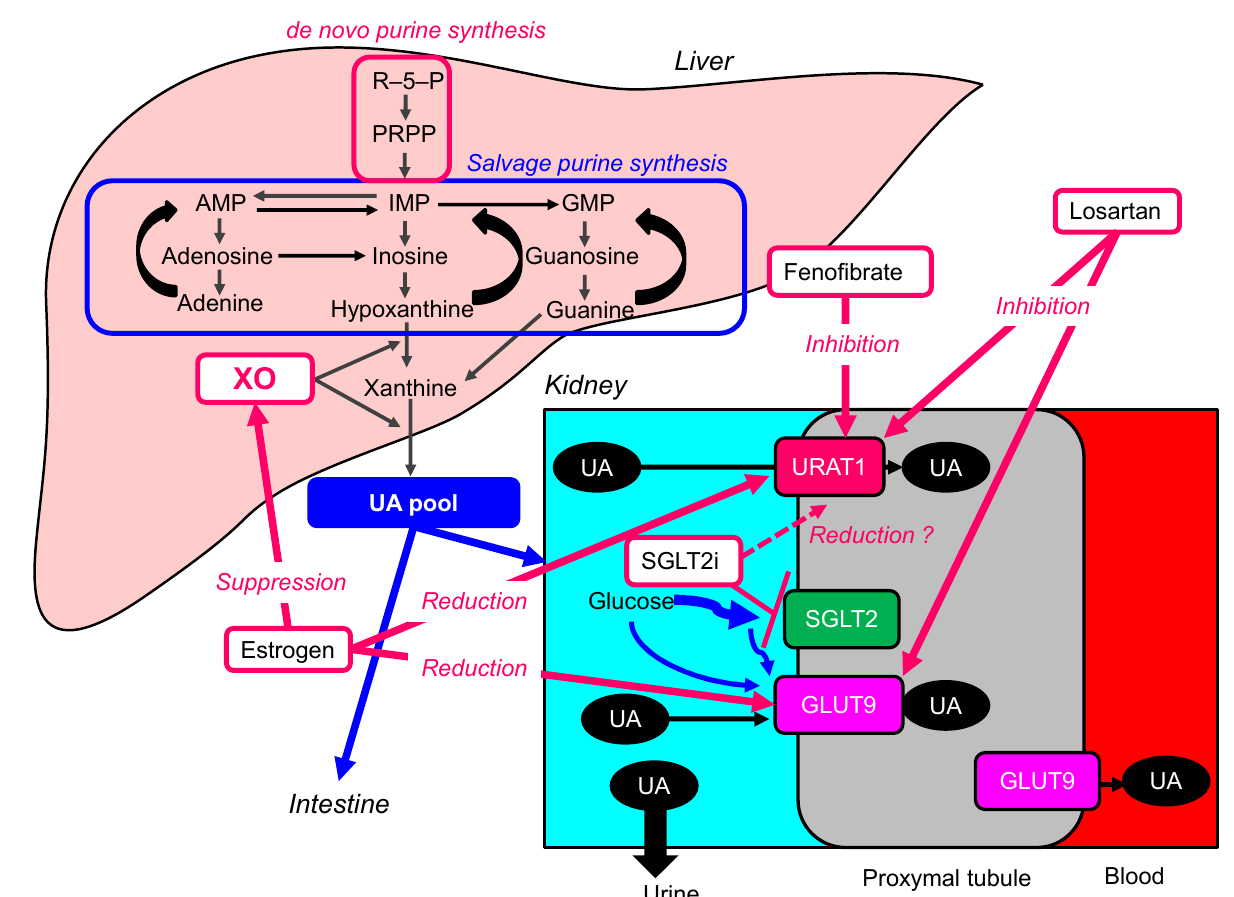
Figure 4. The UA lowering mechanism of non-UA-lowering drugs. AMP, adenosine monophosphate; GMP, guanine monophosphate; GLUT9, glucose transporter 9; IMP, inosine monophosphate; PRPP, phosphor-ribosyl-pyrophosphate; PRS, phosphor-ribosyl-pyrophosphate synthetase; SGLT2i, sodium-glucose cotransporter 2 inhibitors; UA, uric acid; URAT1, urate transporter 1; XO, xanthine oxidase.